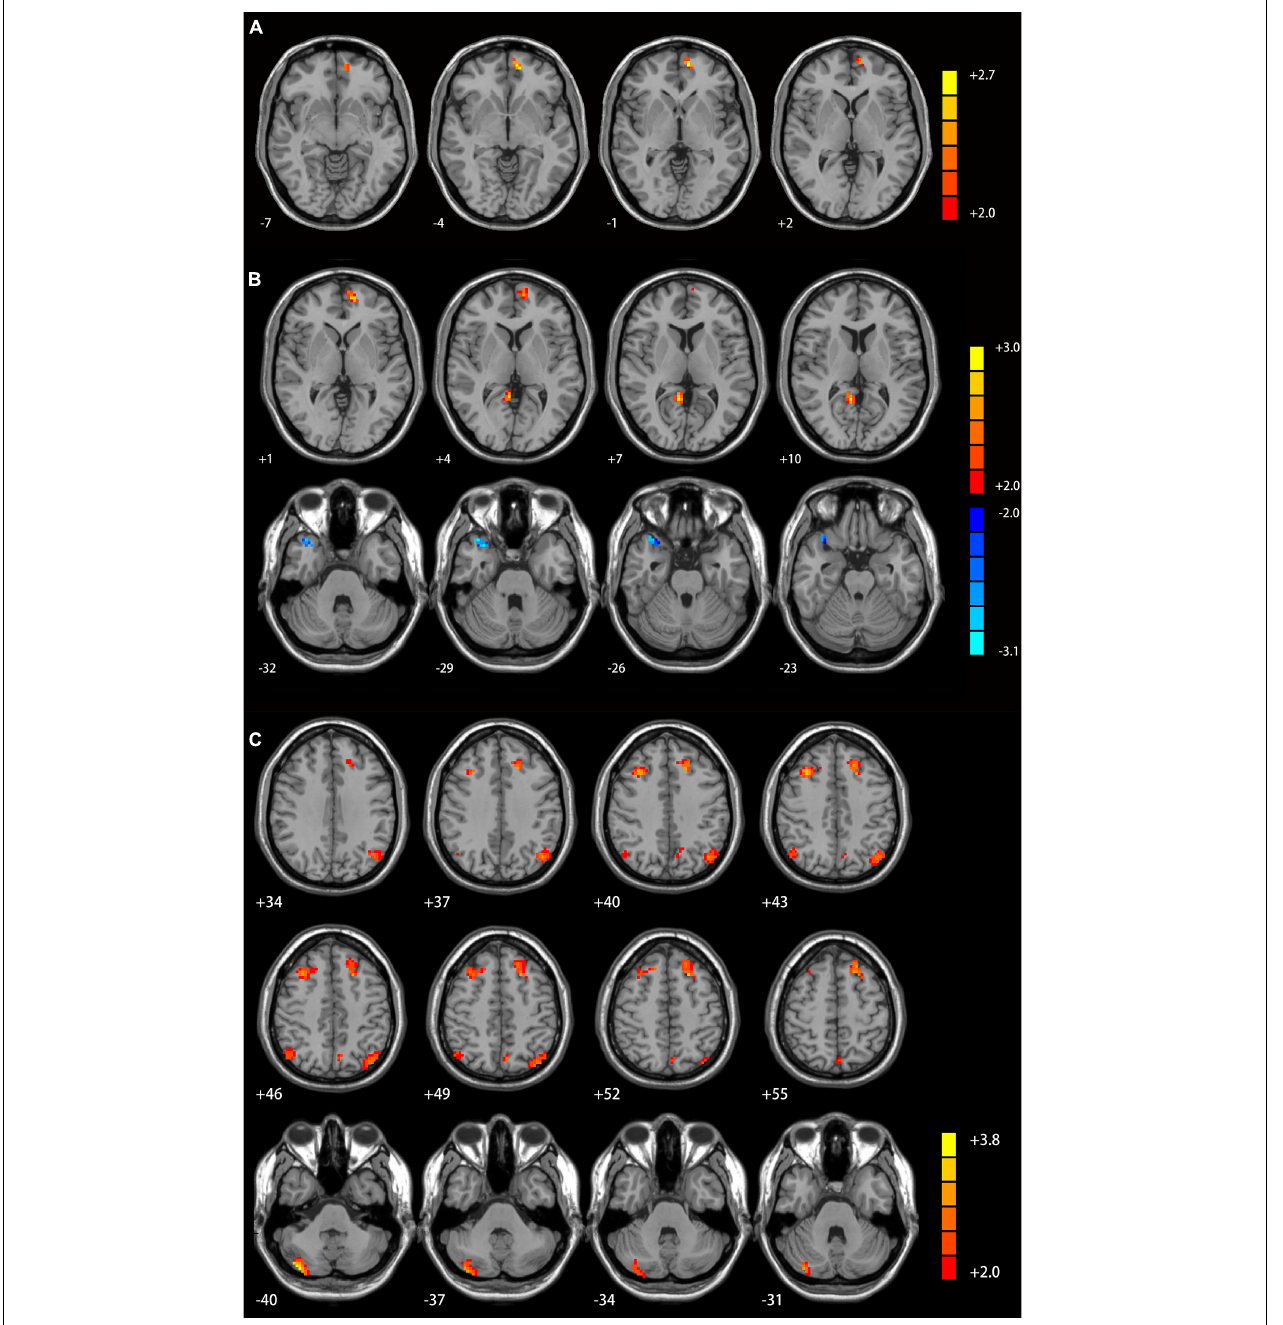
FIGURE 1 | Cerebellar connectivity differences between patients with and without GI symptoms. [ (A) seed left Crus I; (B) seed right Crus I; (C) seed lobule IX]. The color bar indicates the T values. Results were GRF corrected. GI, gastrointestinal symptoms; GRF, Gaussian random field